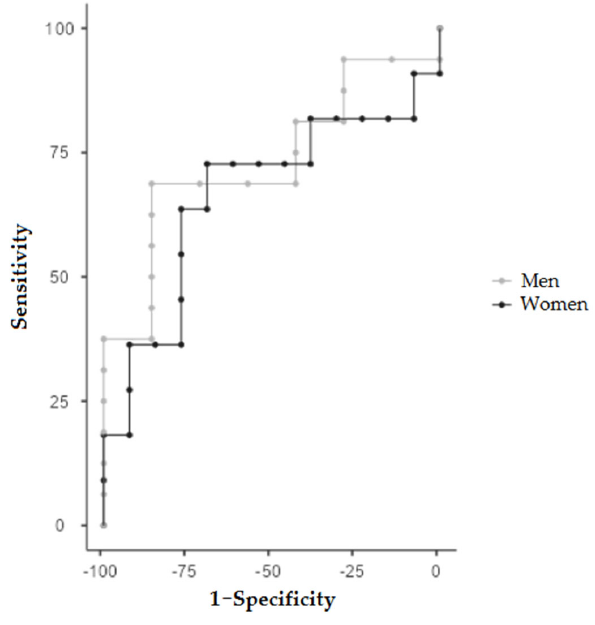
Figure 3. ROC curve analyses for muscular area rectus anterior (MARA) to detect malnutrition.